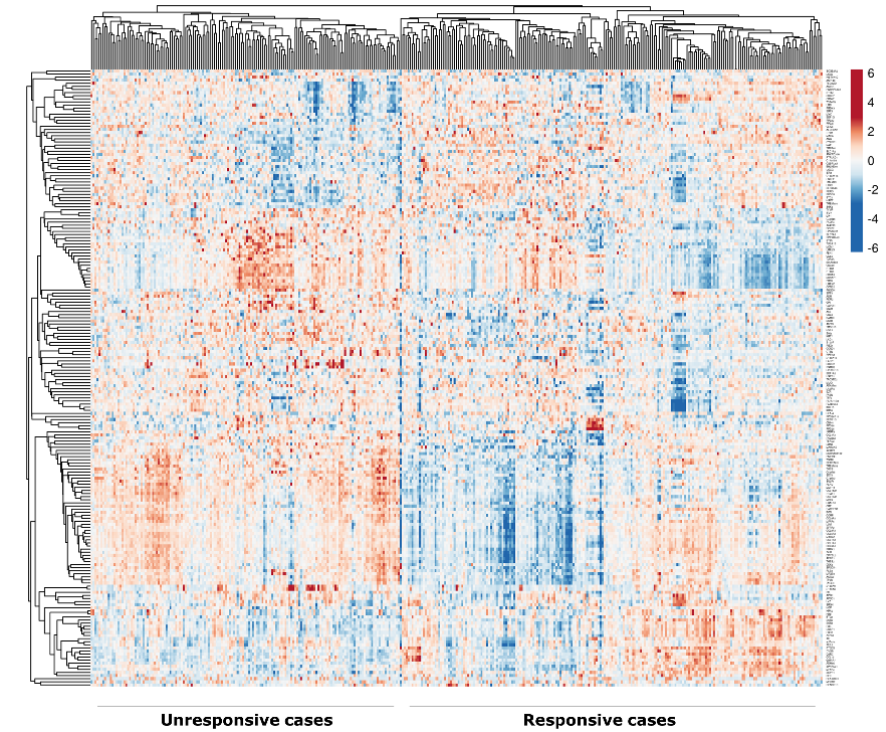
Figure 1. Heatmap of the differentially expressed genes (DEGs) associated with response to endocrine treatment, generated using the ClustVis web tool (Tartu, Estonia). Rows and columns were clustered usingcorrelationdistancesandaveragelinkage.